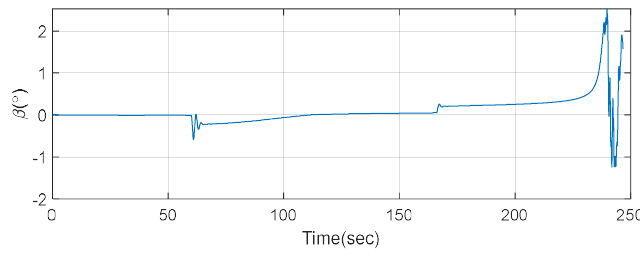
Figure 21. Angle of Attack.